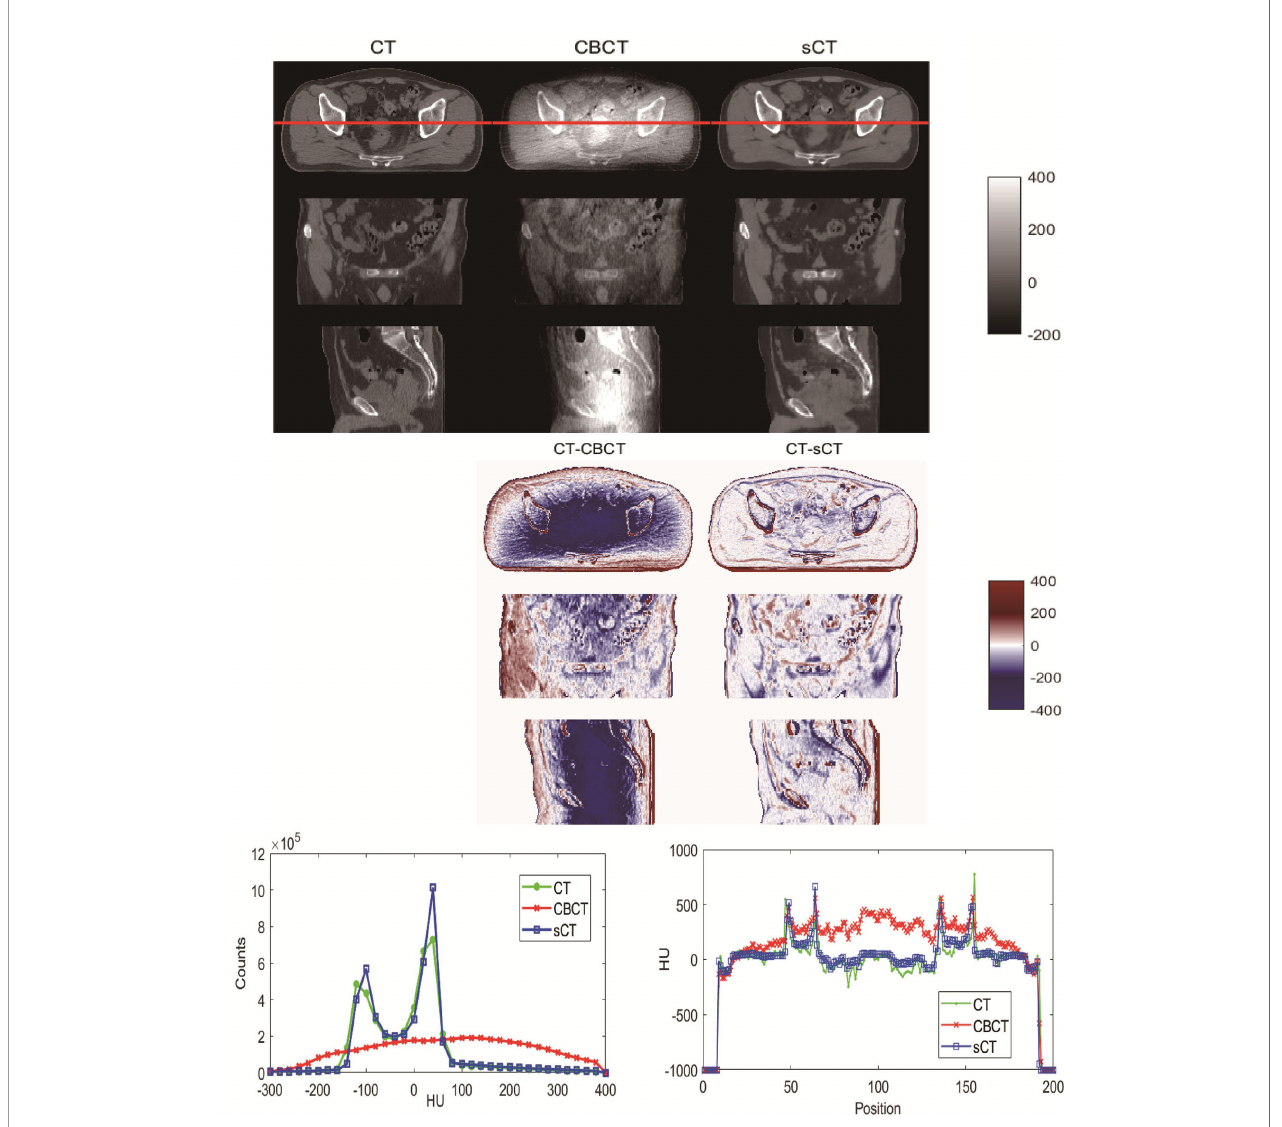
FIGURE 4 | Visual comparison of CT, CBCT and sCT images of one patient. The HU difference between two image sets, HU histogram comparisons and line pro fi le comparisons for CT, CBCT and sCT